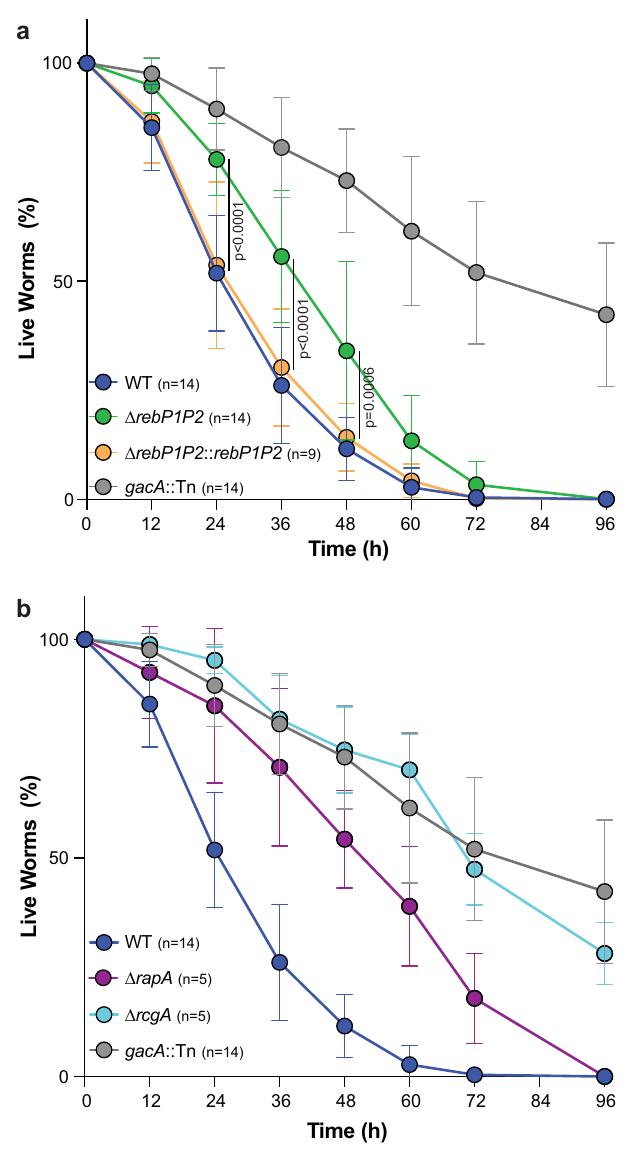
Fig. 6 rebP1P2 and genes in the reb cluster contribute to host killing. a , b Killing kinetics of C. elegans following exposure to P. aeruginosa with the indicated genotypes. The role of gacA in C. elegans pathogenicity has been described previously 41 and gacA :: Tn therefore serves as a control for defective killing in this assay. Error bars denote standard deviation and p values were calculated using unpaired, two-tailed t -tests. n ≥ 5 biological replicates from four experiments. The n values indicate the number of plates, each containing a PA14 lawn and 30 – 40 worms. Data are presented as mean values± strain (Fig. 7c, d). These results, together with the pathogenicity defects of reb cluster gene mutants, (Fig. 6a, b) support the model that R-body-mediated translational inhibition contributes to PA14 virulence in C. elegans .